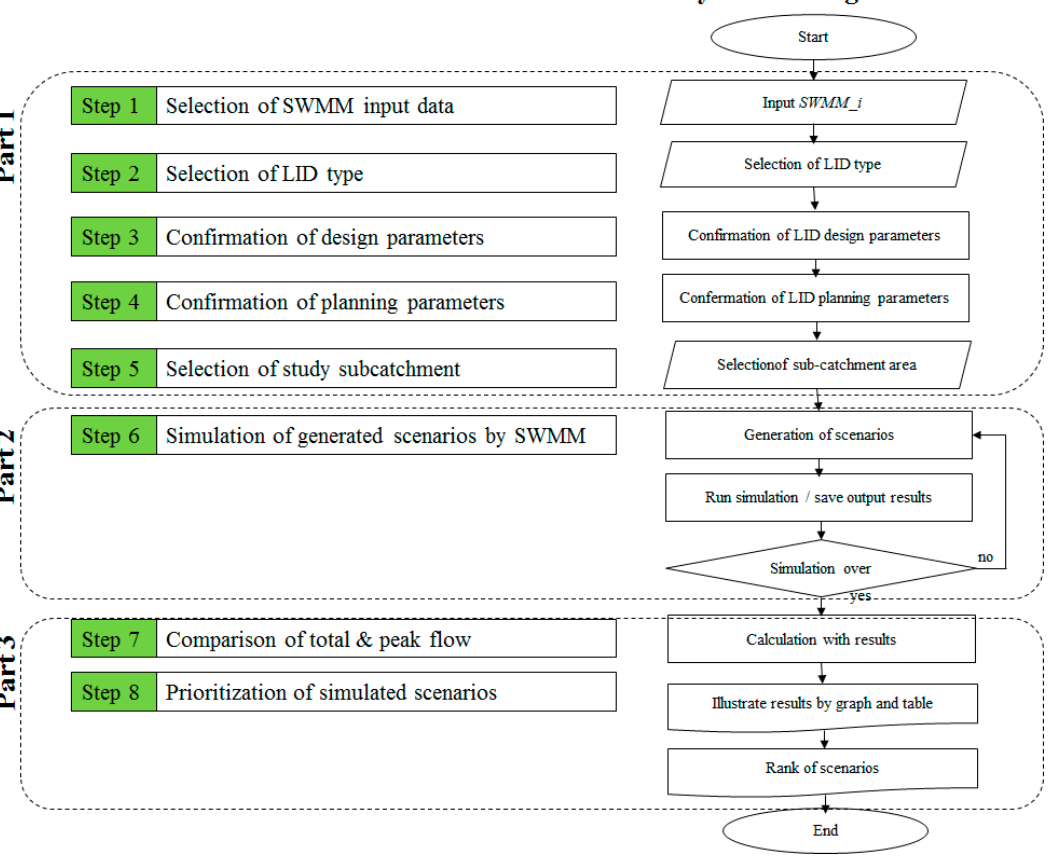
Figure 1. Detail procedure of Water Management Prioritization Module (WMPM).